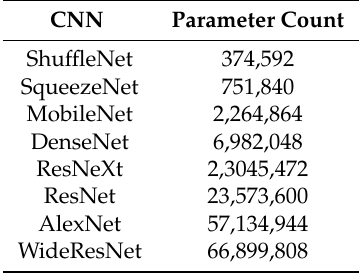
Table 1. CNN Architecture Trainable Parameter